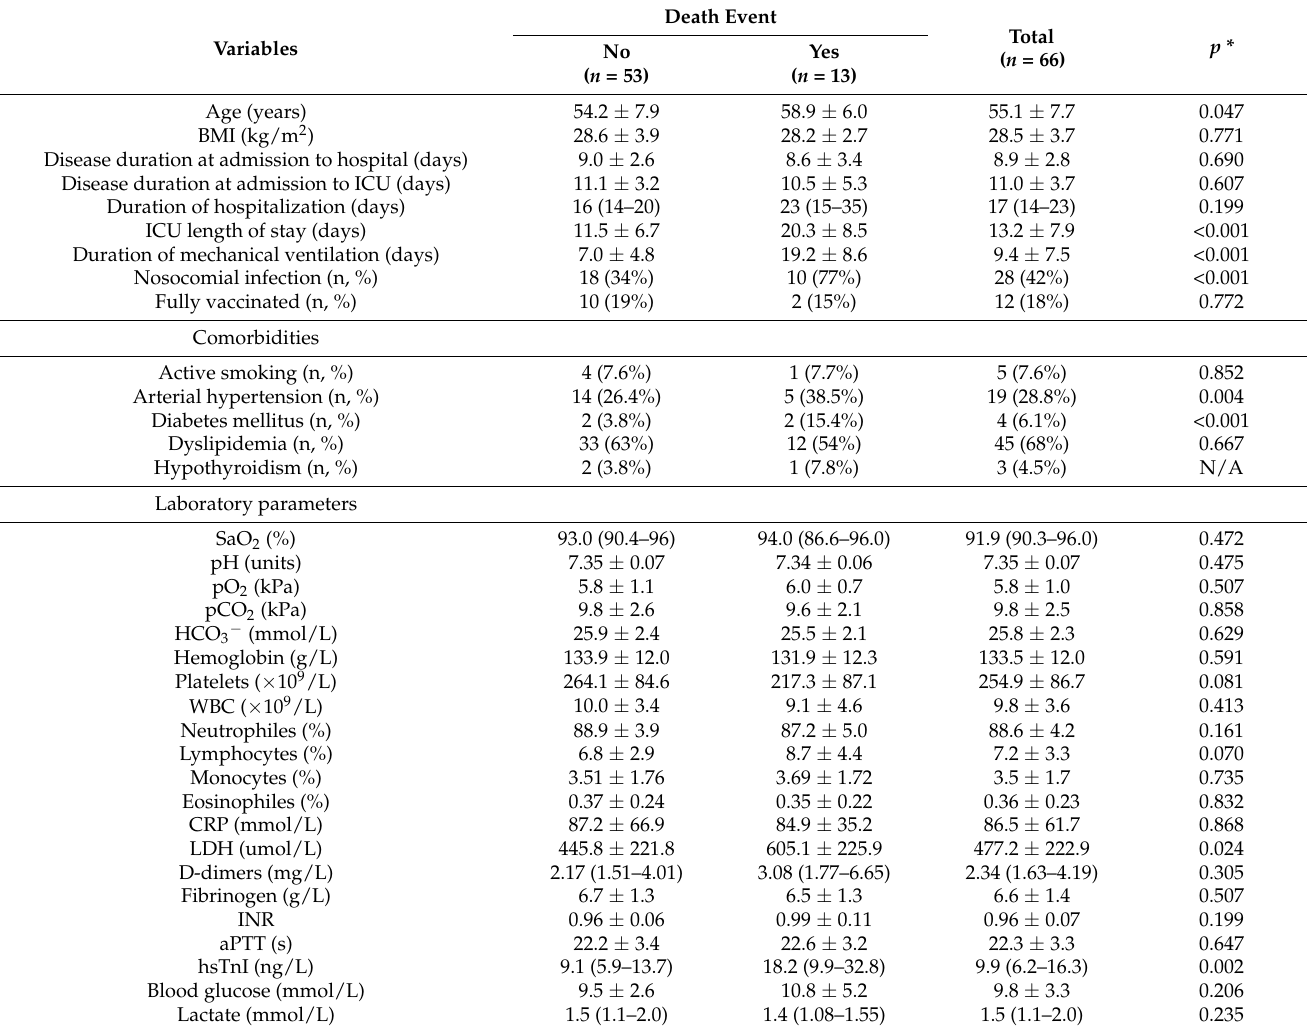
Table 1. Characteristics of patients at admission to the